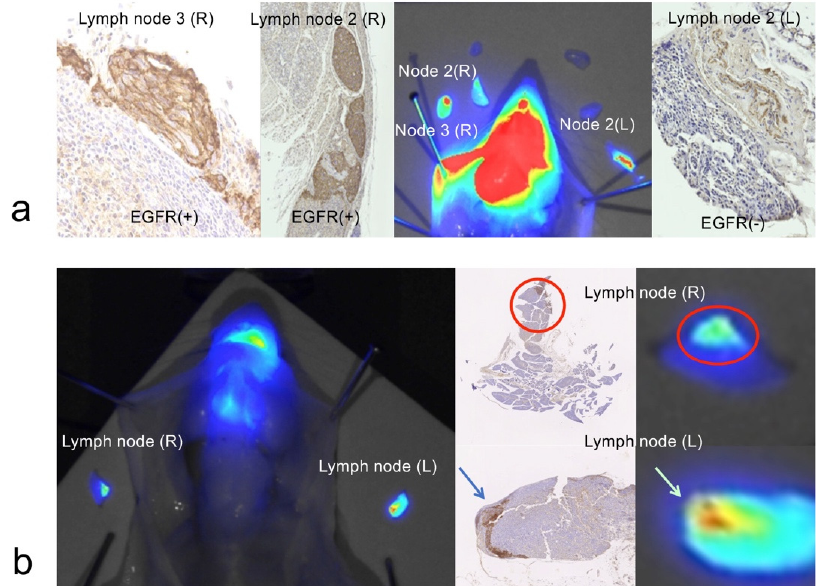
Figure 3. Imaging of metastatic cancer cells in lymph nodes. ( a ) In a mouse lymph node metastasis model, an anti-EGFR affibody probe was injected into the mouse tongue 24 h prior to sacrifice and lymph node dissection. Six lymph nodes were excised; three lymph nodes were highly fluorescent, and the remaining three lymph nodes were not fluorescent. Immunohistochemical staining for EGFR was found in fluorescence-positive lymph nodes (lymph node 2 (R), lymph node 3 (R)). EGFR expression was not visible in the nonfluorescent lymph node (lymph node 2 (L)). ( b ) Two lymph nodes, one from each side of the mouse, were dissected 24 h after anti-EGFR affibody probe injection into the tongue. The indocyanine green (ICG) fluorescence signal was obvious and corresponded to the immunohistochemically stained EGFR expression in the lymph nodes (red circles and arrows). The panel on the right is a magnified view of the two lymph nodes in the left panel of the NIR images.